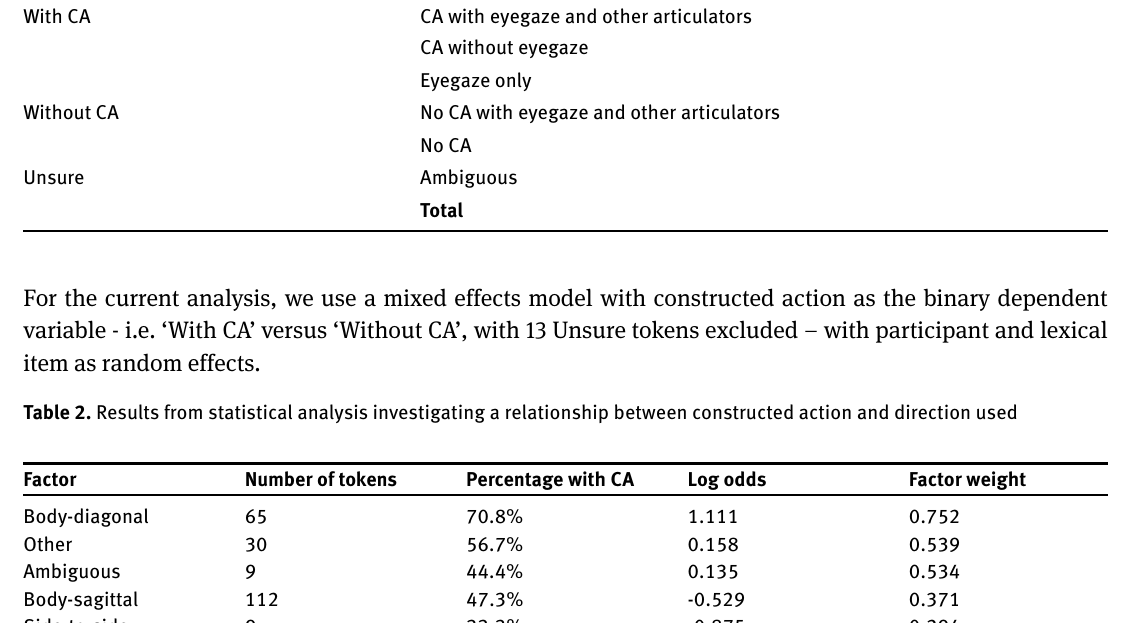
Table 1. Total set of constructed action/eyegaze categories coded Collapsed constructed action categories